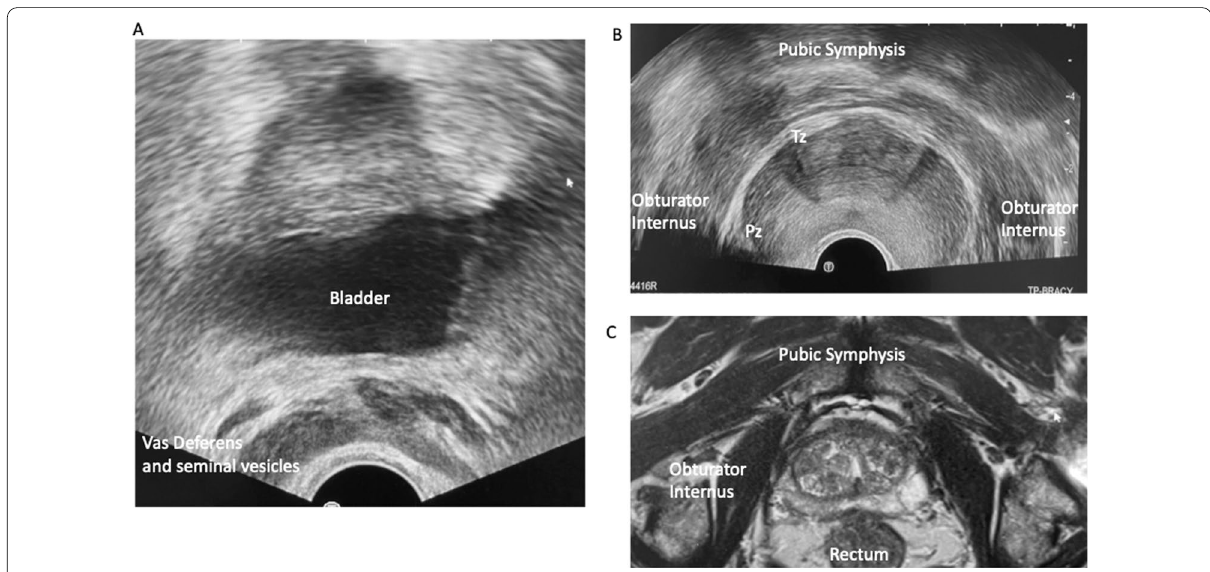
Fig. 5 A shows axial ultrasound anatomy superior to the prostate. B and C show the gland and surrounding structures at its mid-level on ultrasound and T2-weighted MRI, respectively. The peripheral zone (Pz) and transitional zone (Tz) can be identified in